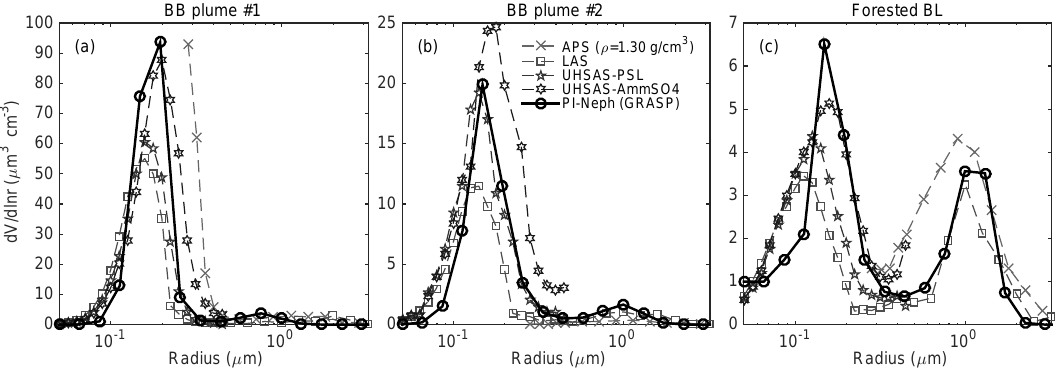
Figure 11. Direct comparisons of size distributions retrieved using GRASP with dedicated particles sizers that sampled in parallel to the PI- Neph. The three cases selected show measurements from the (a) 19 August and (b) 27 August biomass-burning cases, as well as (c) boundary layer measurements made above a forested region of southeastern Missouri on 30 August.